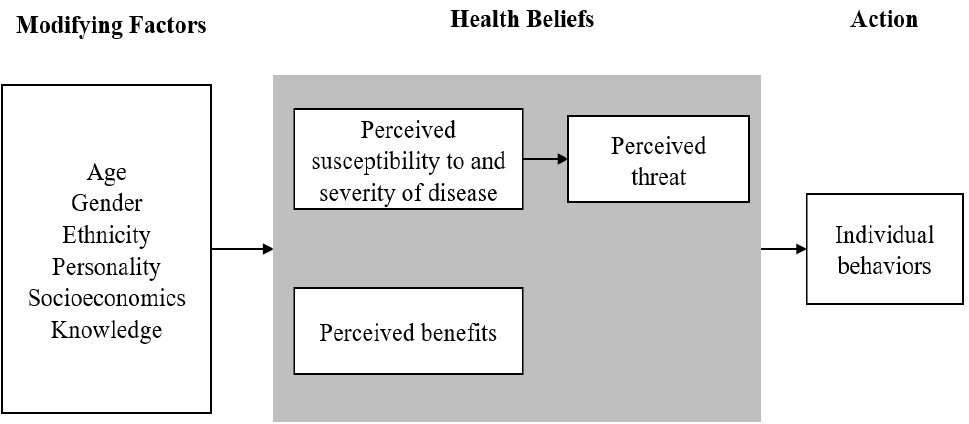
Figure 1. HBM-based model of COVID-19 vaccination acceptance. Notes: this model is adjusted by Rosenstock’s HBM . According to the HBM, the survey consisted of three dimensions, namely socio-de- mographic characteristics, health beliefs and acceptance towards COVID-19 vaccination.